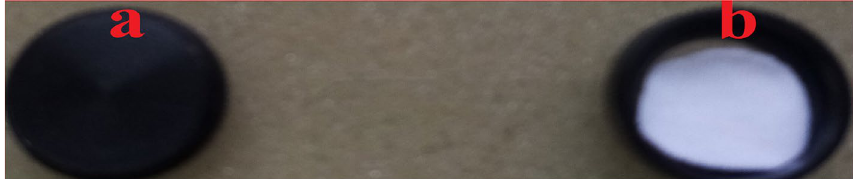
Figure 4. Blank sample port ( a ) and standardized barium sulphate placed on sample port ( b ) for assessment with UV–Vis–NIR spectrophotometer.